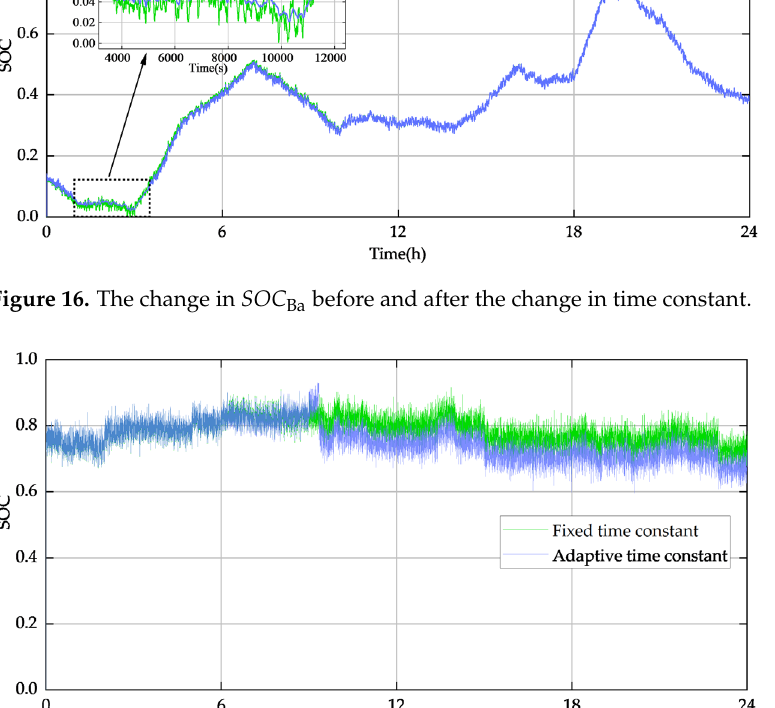
Figure 17. The change in SOC Sc before and after the change in time